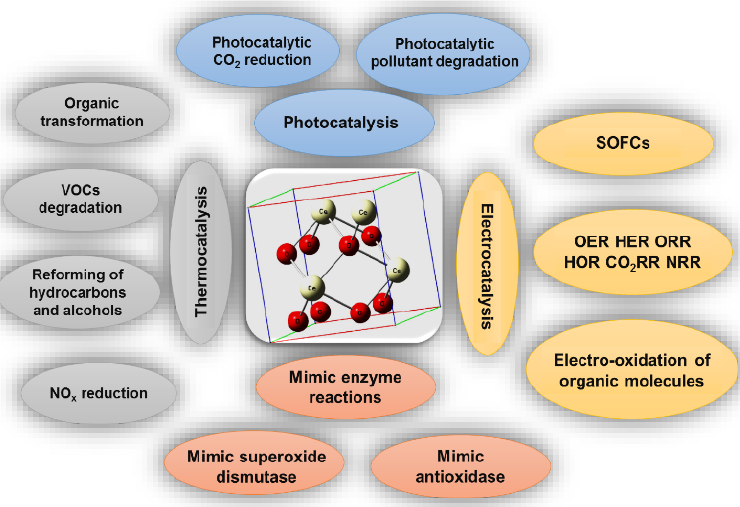
Figure 6. Overview of catalytic applications of CeO 2 -based materials. Adapted from Ref. [19]. Copyright© 2021, American Chemical Society.